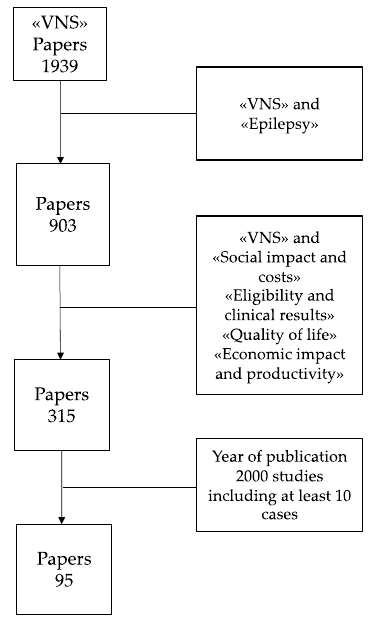
Figure 2. Literature search progression.